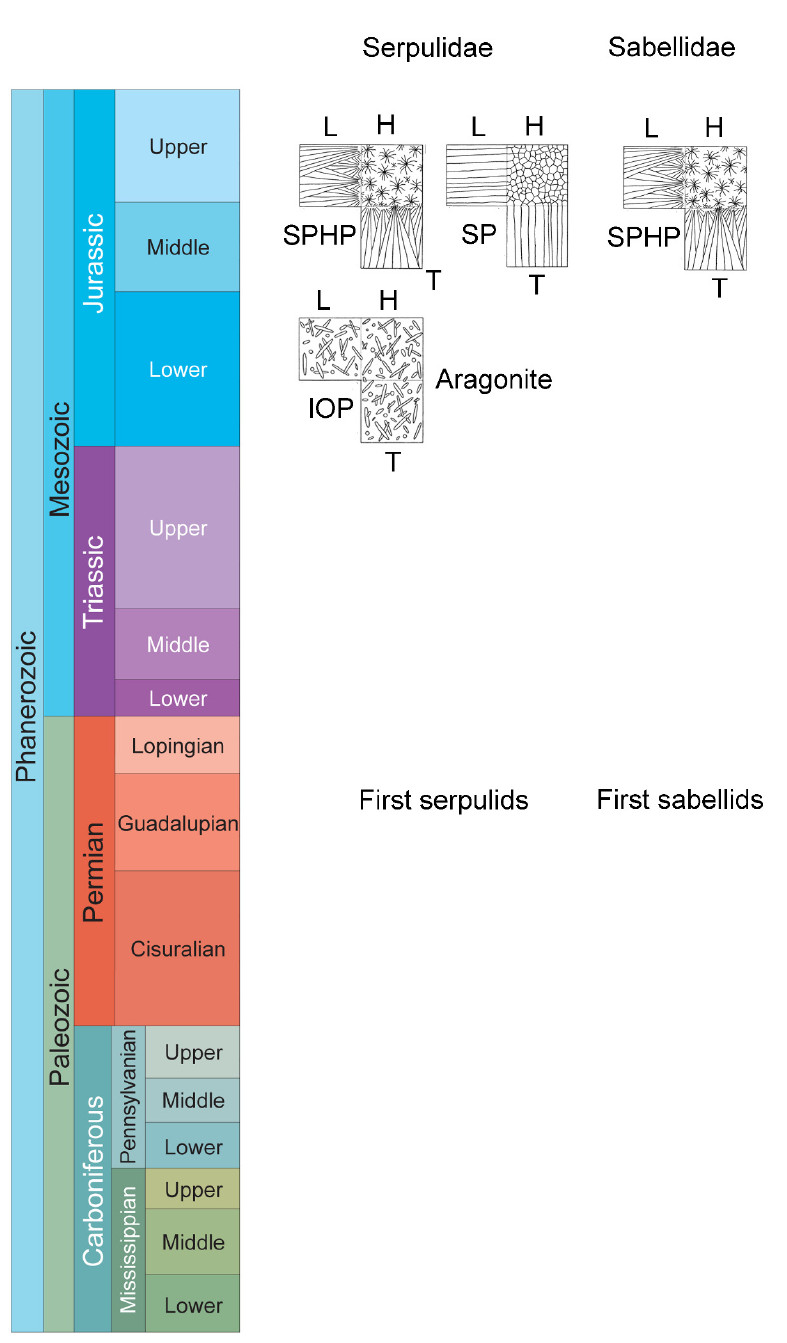
Figure 3. First appearances of tube microstructures and mineral composition in calcareous polychaetes (Permian to Jurassic). IOP—irregularly oriented prismatic structure, SPHP—Spherulitic prismatic structure, SP—simple prismatic structure. Stratigraphy modified based on the International Stratigraphic Chart